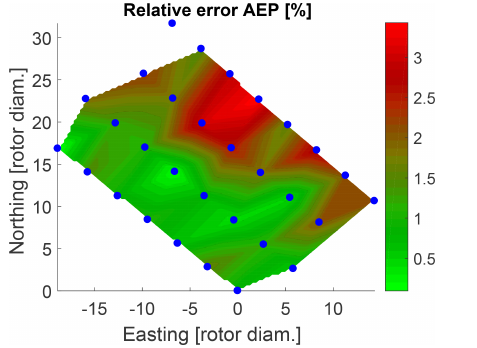
Figure 19. Estimated normalized DEL of torsional moment on main bearing within wind farm for normal operation including start- up and shutdown events.